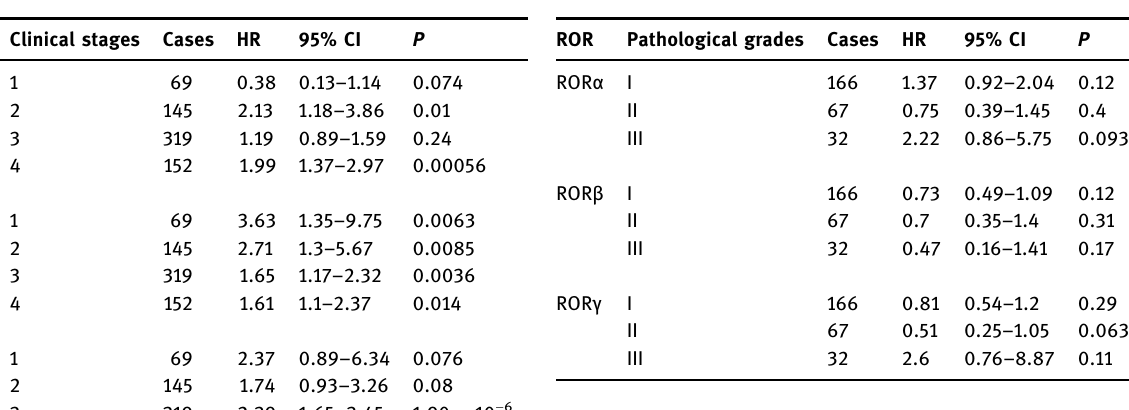
Table 3: Correlation of RORs mRNA expression with pathological grades of patients with GC